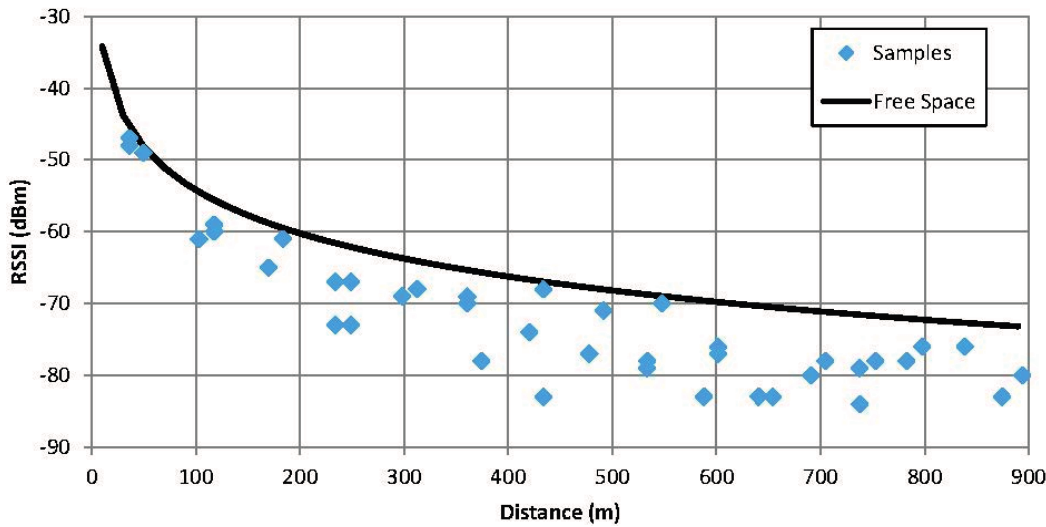
Figure 11. RSSI of the received remote name